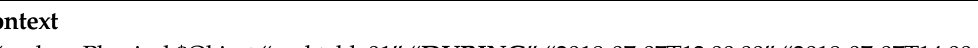
Figure 8. An example of a context query using a time-point operator.